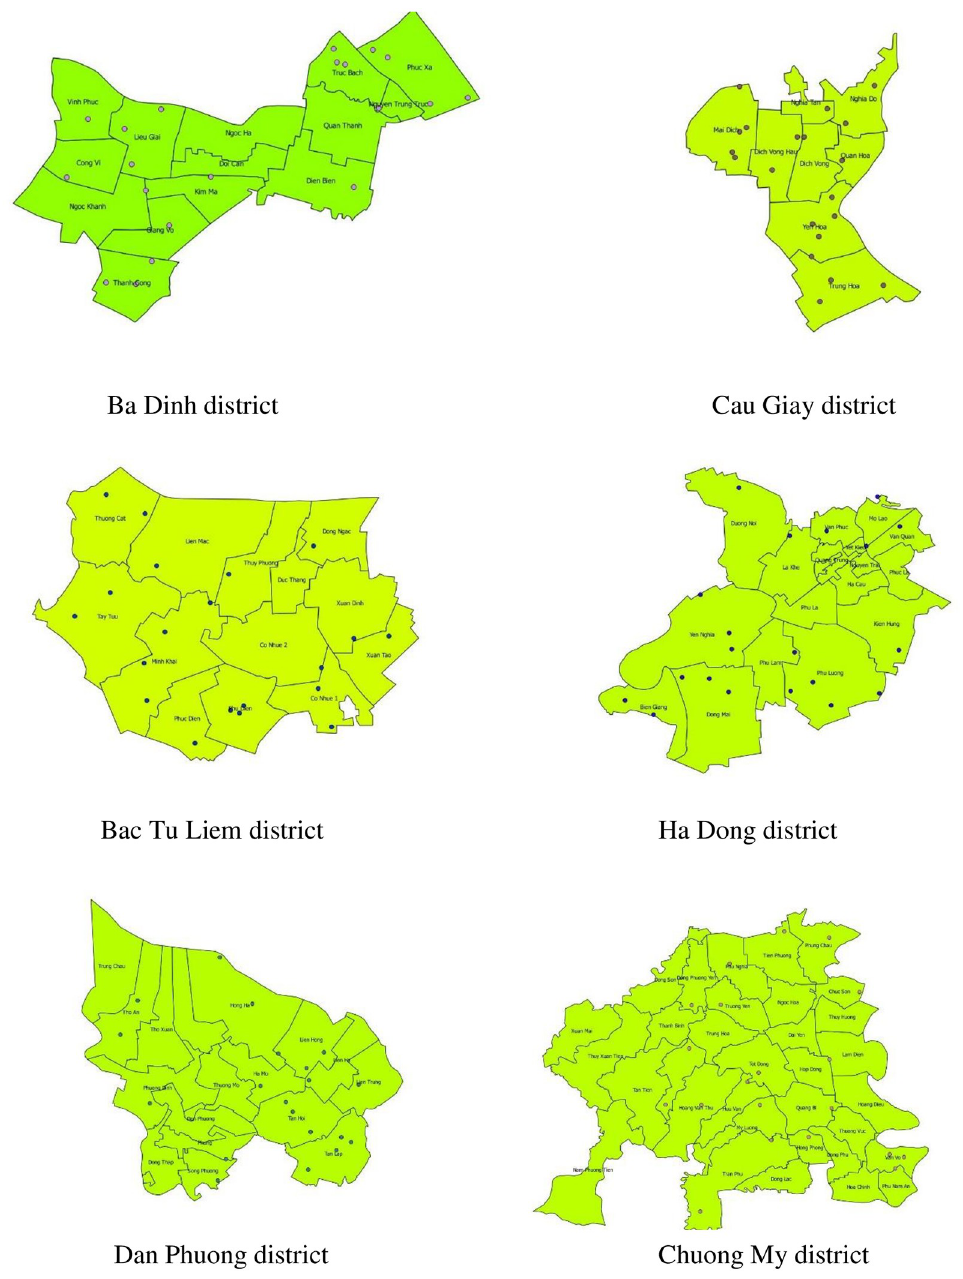
Fig 2. GPS points in 6